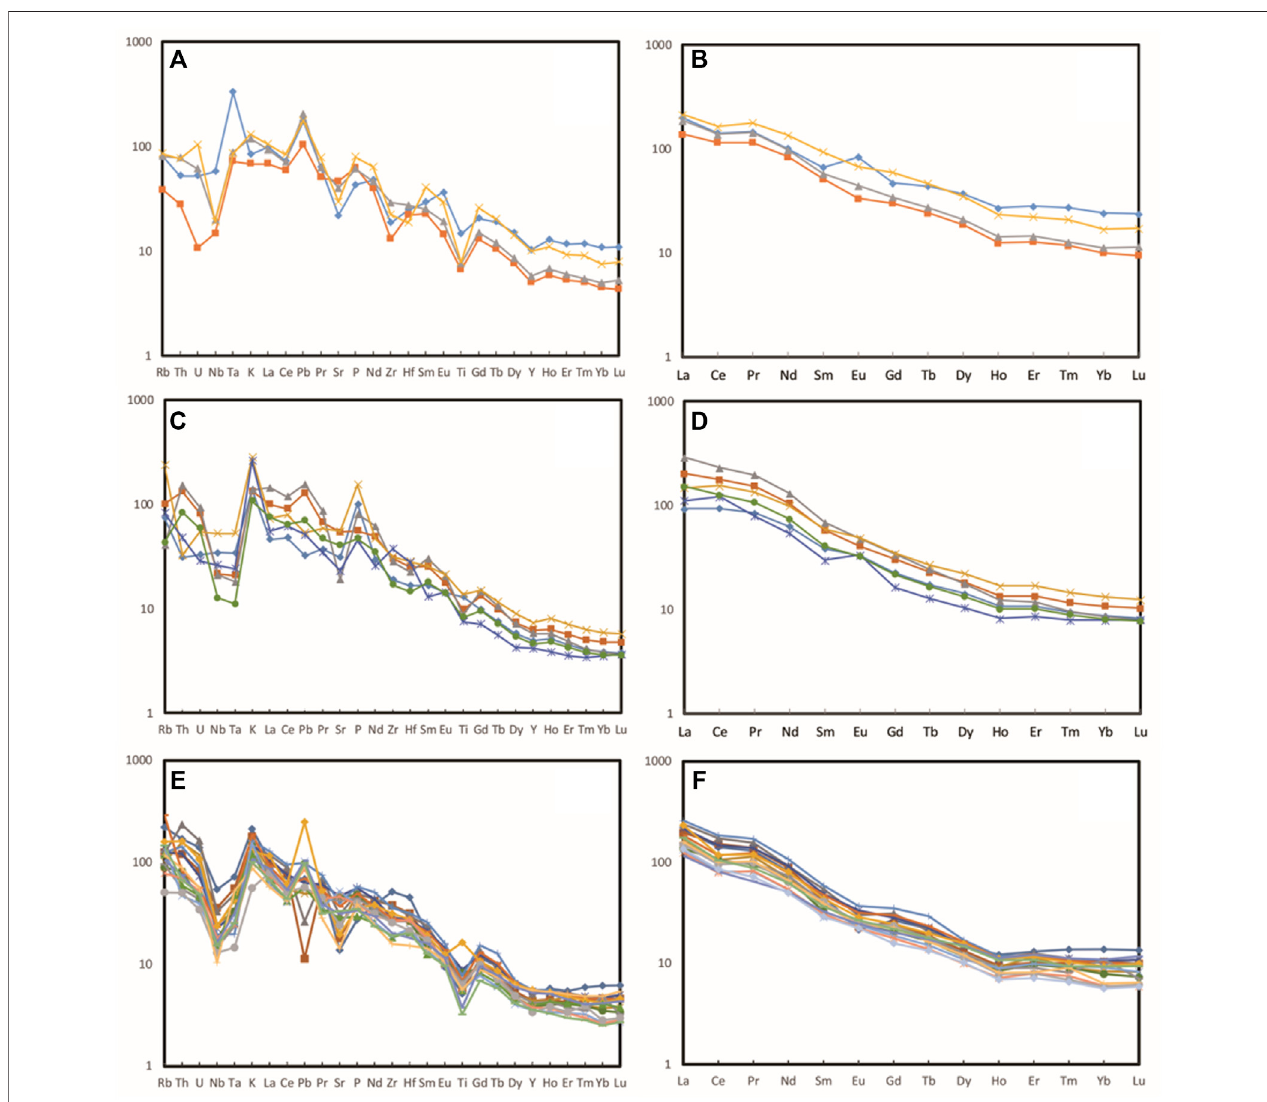
FIGURE11| StandardizedanalysisofigneousrockintheLaohuzuisection andsurroundingareas. (A) StandardizationofREEchondritesinigneousrocksamples from the Laohuzui section. (B) Original crustal standardization of trace elements in igneous rock samples from the Laohuzui section. (C) Standardization of REE chondritesinigneousrocksamplesfromthelamprophyreinthelowerpartoftheLaiyangGroup,datafromWangetal.(2015). (D) Originalcrustalstandardizationoftrace elementsinigneousrocksamplesfromthelamprophyreinthelowerpartoftheLaiyangGroup,datafromWangetal.(2015). (E) StandardizationofREEchondrites inigneousrocksamplesfromtheZhucheng-Taolinarea,datafromZhangetal.(2017). (F) Originalcrustalstandardizationoftraceelementsinigneousrocksamplesfrom the Zhucheng-Taolin area, data from Zhang et al. (2017).